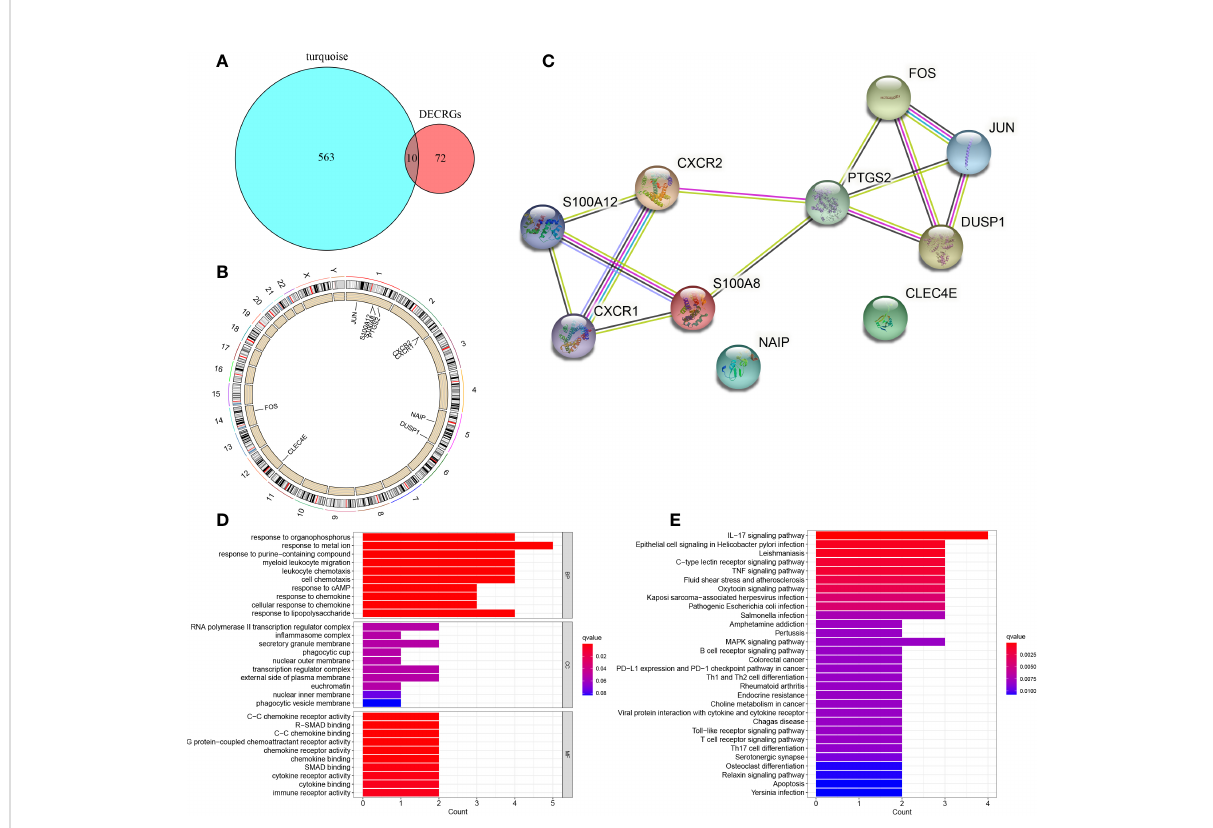
FIGURE 5 Identi fi cation of 10 hub CRGs. (A) The 10 hub CRGs were obtained by determining the intersection of DECRGs and genes in the turquoise module. (B) The speci fi c location of each CRG on the chromosome. (C) PPI network of the 10 hub CRGs (10 nodes and 13 edges). (D) GO terms in the enrichment analysis of the 10 CRGs. (E) KEGG terms in the enrichment analysis of the 10